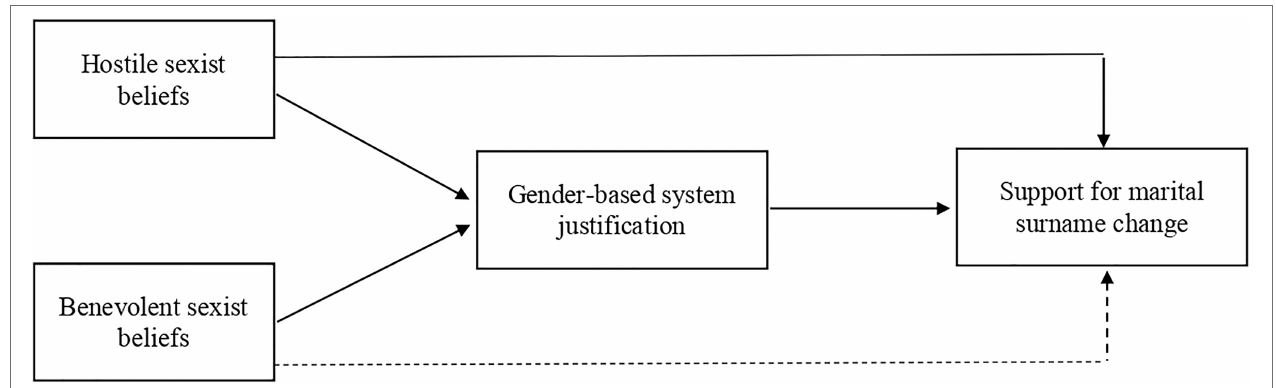
FIGURE 1 | A theoretical model depicting the indirect and direct relationship between hostile and benevolent sexism on support for marital surname change through gender-based system